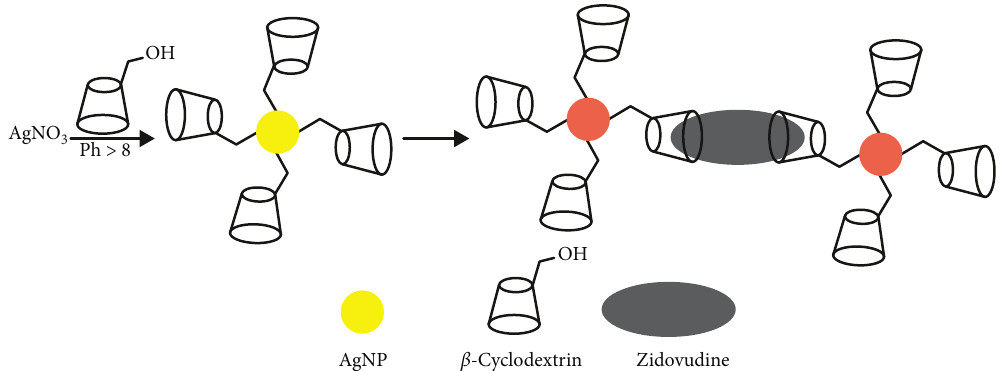
Scheme 2: Schematic diagram of calorimetric detection of zidovudine based on β -CD and its interaction with AgNPs.